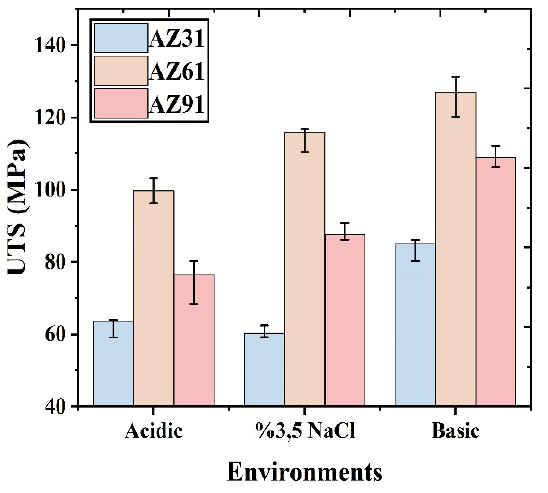
Figure 4: Ultimate tensile strength of AZ31, AZ61 and AZ91 Mg alloys in different media.